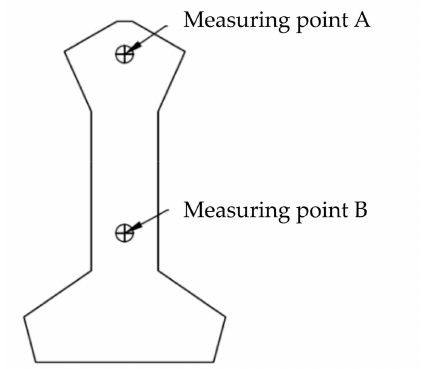
Figure 19. Deformation monitoring point of the middle partition